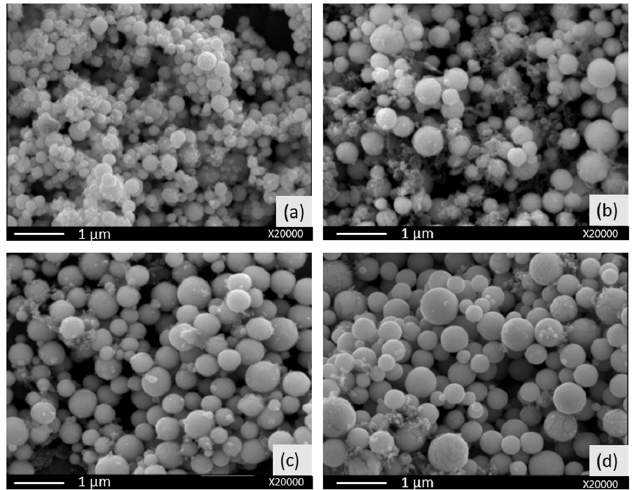
Figure 6. SEM analyses of AgCu nanosized particles, ( a ) 0.05 mol/L, ( b ) 0.1 mol/L, ( c ) 0.2 mol/L and ( d ) 0.4 mol/L.